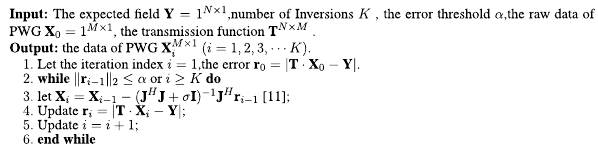
Algorithm 1. The GNI algorithm in PWG systems.